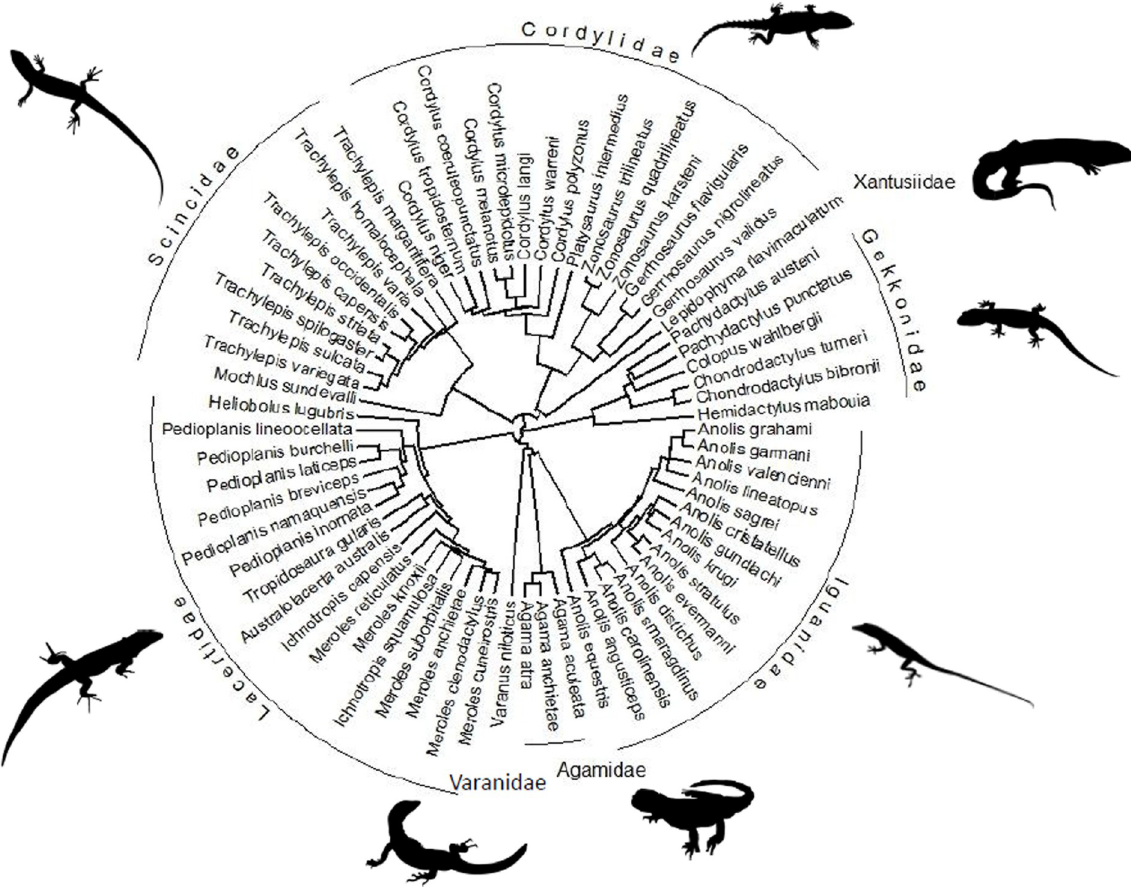
Fig 2. Phylogenetic relationships among the 68 lizard taxa from 8 families included in the final model. Note that phylogeny had no effect on the predictive accuracy of the final, stacked model.